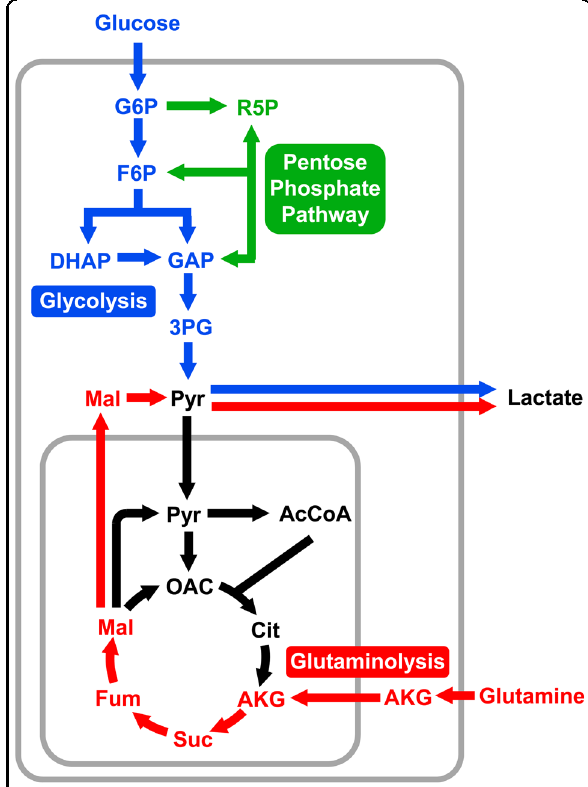
Fig. 1 Glucose and glutamine are the two most highly consumed carbon substrates in cancer cells. Both substrates can be converted to lactate via glycolysis and glutaminolysis, respectively. High lactate secretion, especially from glucose, is a major hallmark of cancer cells known as the Warburg effect, or aerobic